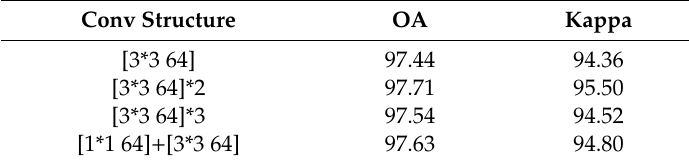
Table 4. Comparison of di ff erent convolution structures after combining